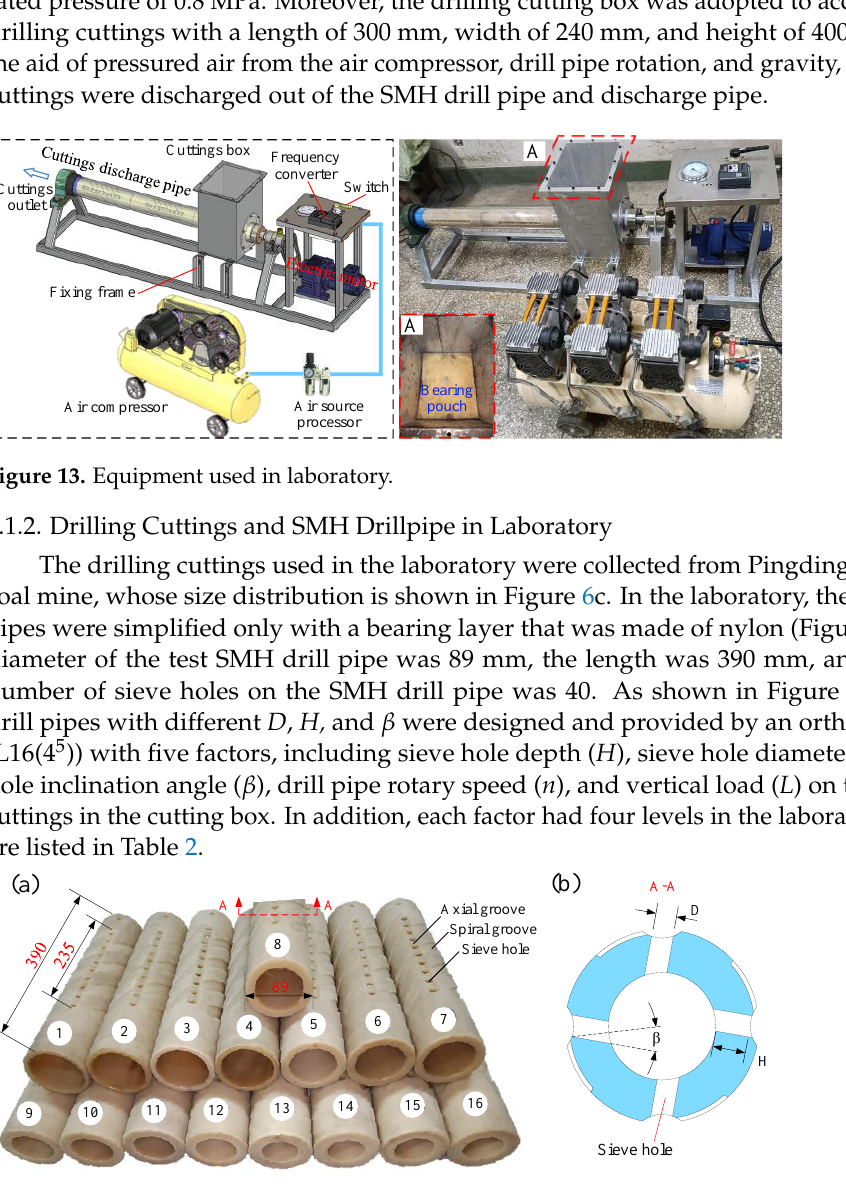
Figure 14. Structure and size of SMH drill pipes for test. ( a ) SMH drill pipe; ( b ) view of cross